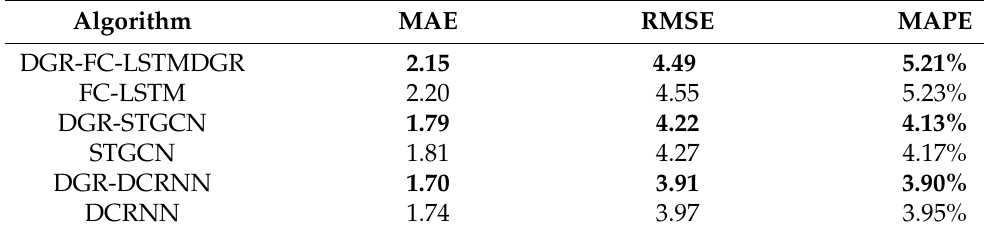
Table 3. Performance indices under different models combined with DGR